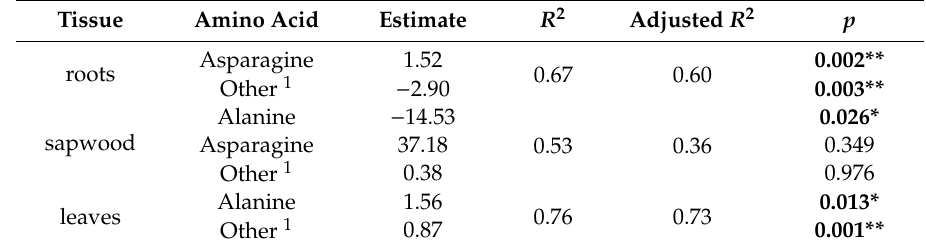
Table 4. Summary statistics of the multiple regression analysis of the e ff ect of 19 free amino